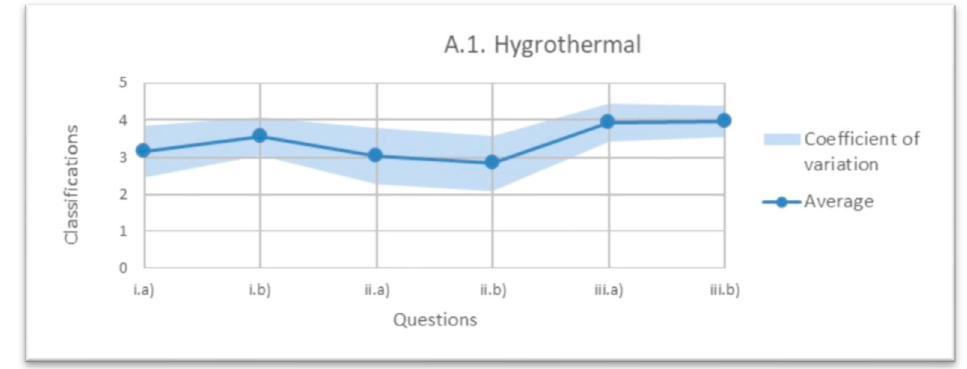
Figure 2. Average ratings of hygrothermal conditions.